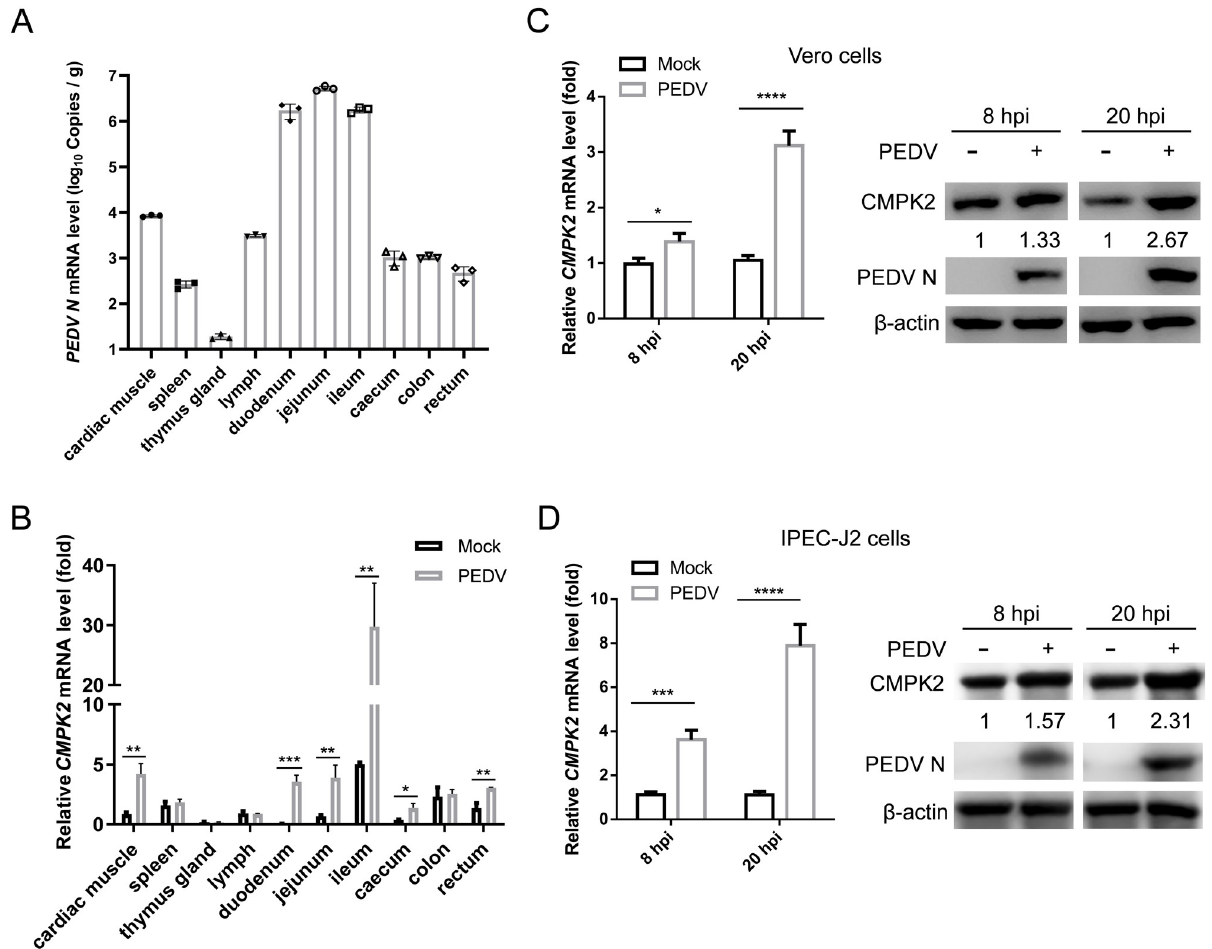
Fig 1. PEDV infection up-regulates CMPK2 expression. (A and B) At 7 dpi with PEDV, viral copy numbers in per g of tissue ( A ) and relative transcriptional levels of CMPK2 ( B ) in piglet tissues ( N = 3) were, respectively, analyzed with a standard curve and qRT-PCR. (C and D) Vero and IPEC-J2 cells were infected with PEDV (MOI = 1) and harvested at 8 and 20 hpi, respectively. The expression of CMPK2 were detected by qRT-PCR (left) and western blot (right). Data are means ± SD of triplicate samples; statistical analysis was conducted using two-way ANOVA followed by Tukey’s multiple comparison test; only the p -value for the most relevant comparisons are shown for simplicity. The intensities of bands were quantified by ImageJ. � p < 0.05, �� p < 0.01, ��� p < 0.001, ���� p < 0.0001. Data underlying this figure can be found in S1 Data and S1 Raw Images. CMPK2, cytidine/ uridine monophosphate kinase 2; dpi, days post-infection; hpi, hours post-infection; MOI, multiplicity of infection; PEDV, porcine epidemic diarrhea virus; qRT-PCR, quantitative real-time